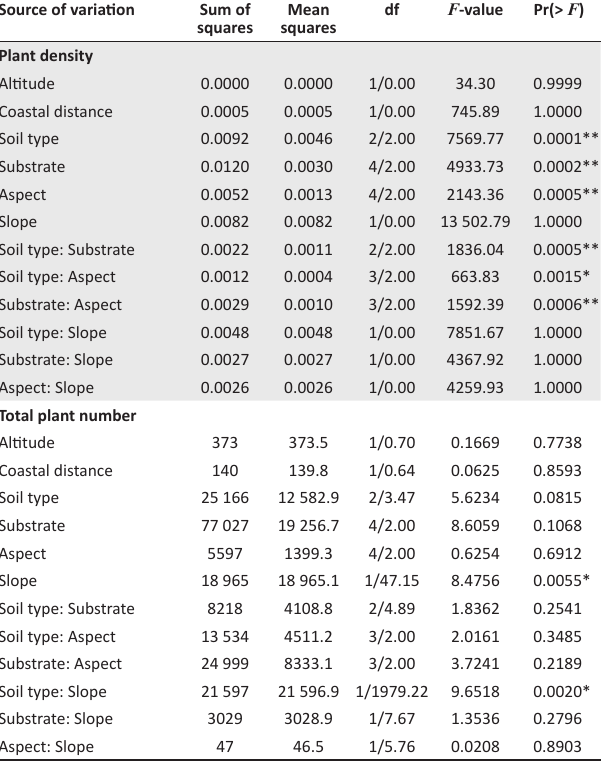
TABLE 5: Factors and co-variables selected by a general linear mixed model to explain variation in plant density and total plant number for 26 sites at the other eight